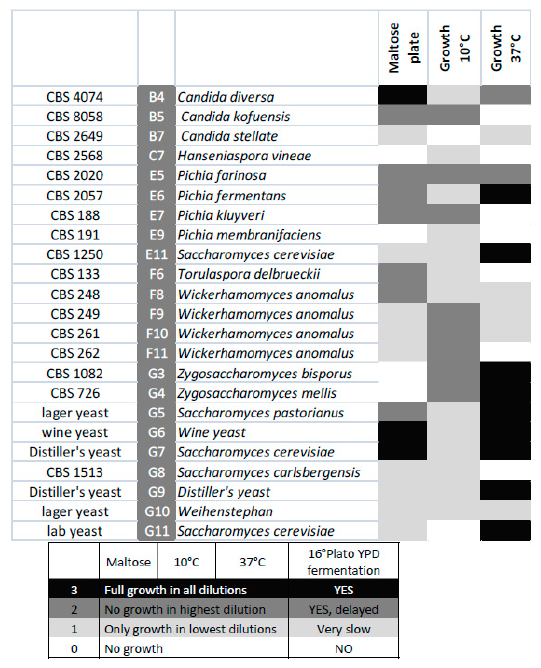
Figure 5. Heat map displaying maltose utilization and growth at the indicated temperatures of the selected strains.